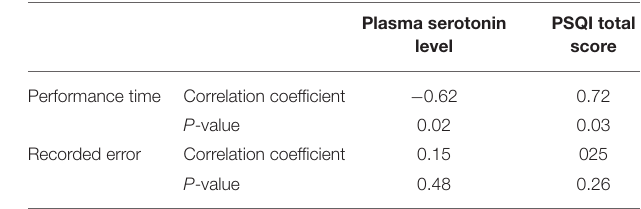
TABLE 3 | Correlations between motor skill acquisitions and sleep quality measures.in the PD and healthy control participants. Sleep quality measures